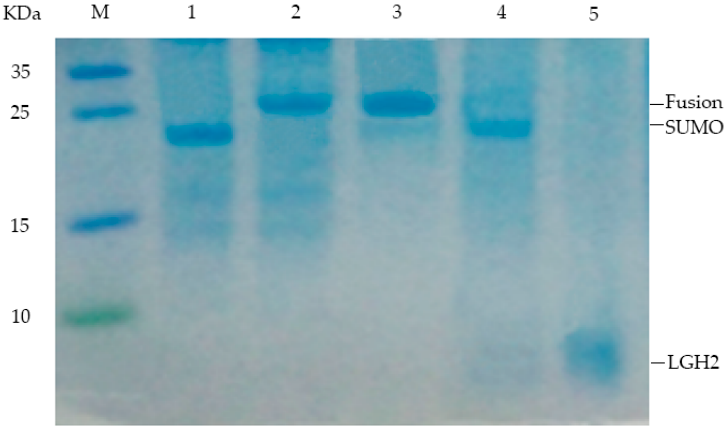
Figure 4. Analysis of expressed fusion protein and LGH1 by 16.5% Tricine-SDS–PAGE. Lane M, molecular mass marker; Lane 1, negative control; Lanes 2, colony induced by 0.5 mM IPTG; Lane 3, purified product of fusion protein isolated by Ni-Affinity column; Lane 4, production of fusion protein hydrolyzed by enterokinase; Lane 5, purification of LGH2 isolated by RP-HPLC.